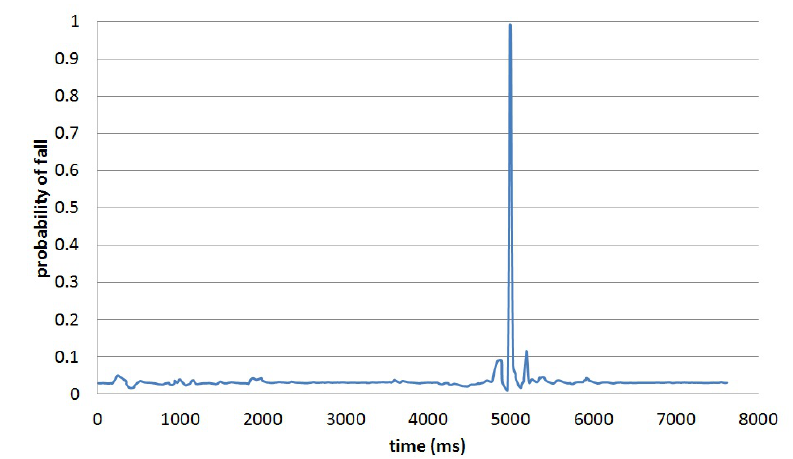
Figure 10. Probability of a fall for Data Sample 9 in the database. Table 6. Fall detection algorithm parameters.